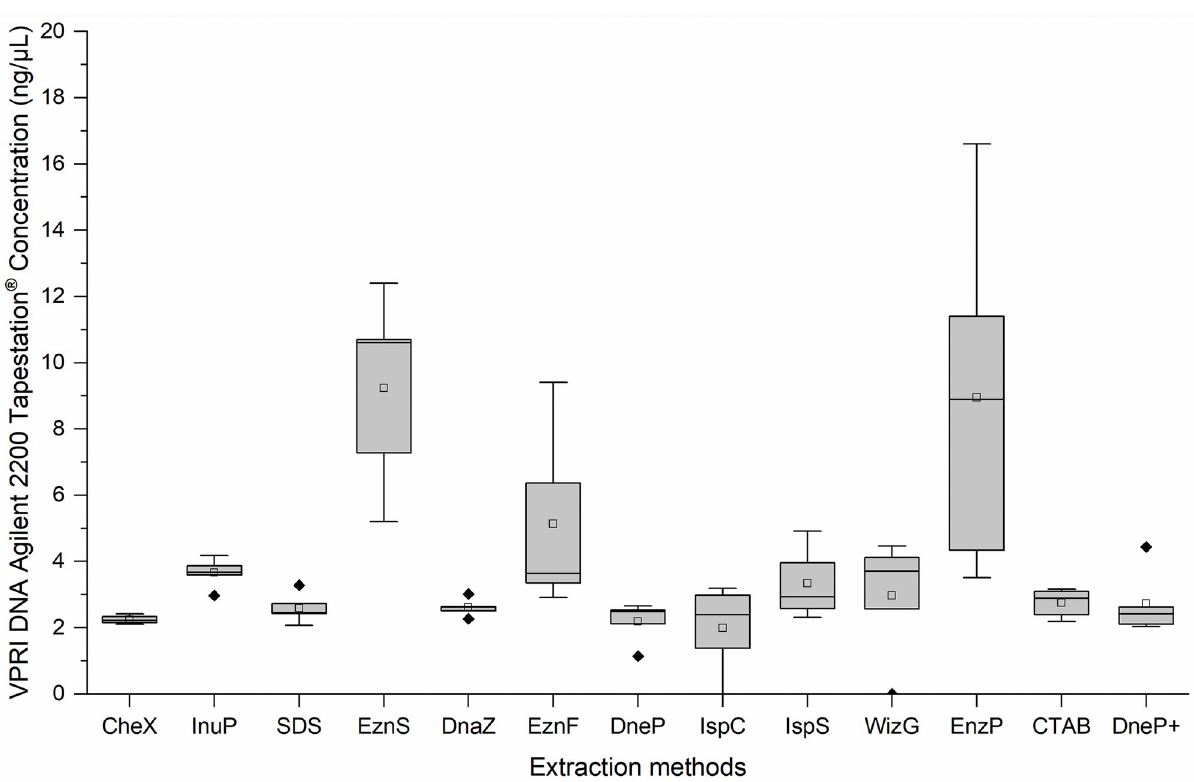
Fig 2. Box plots of the DNA concentrations (ng/ μ L) of five victorian plant pathology herbarium (VPRI) apple powdery mildew specimens produced by 13 extraction protocols, as measured by agilent 2200 Tapestation 1 DNA. Median line __ ; Mean □ ; Outlier Extraction method abbreviations: Chelex 1 100 (CheX), innuPrep Plant DNA (InuP), sodium dodecyl sulphate (SDS), E.Z.N.A. 1 SP Plant (EznS), DNAzol ™ (DnaZ), E.Z.N. A. 1 Forensic DNA (EznF), Qiagen DNeasy 1 Plant (DneP), Isolate II Plant DNA Lysis buffer PA1 C (IspC), Isolate II Plant DNA Lysis buffer PA2 S (IspS), Wizard 1 Genomic DNA Purification (WizG), E.Z.N.A. 1 Plant (EznP), Cetyl trimethyl ammonium bromide (CTAB) and Qiagen DNeasy 1 Plant plus PTB